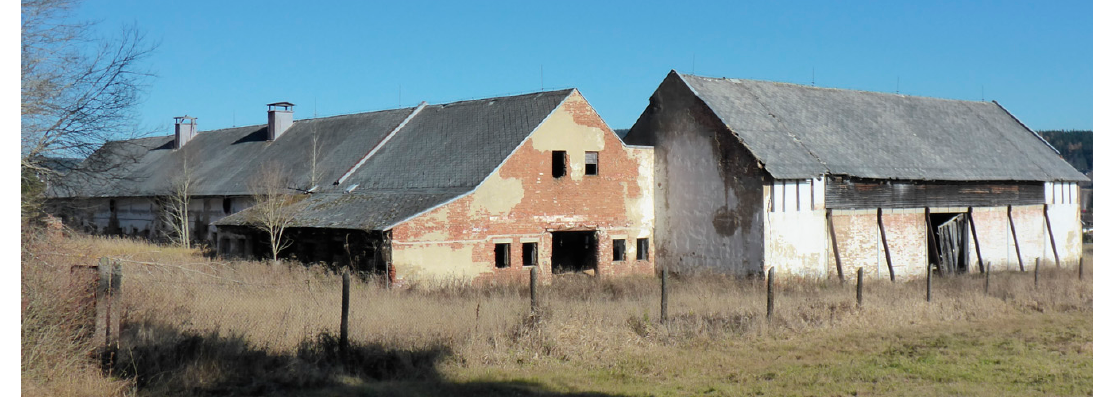
Figure 1. Typical view of an abandoned cowshed, part of a former collective farm. Image by Tomáš Krej č í (Borová Lada, the Czech Republic, 21 October 2020).